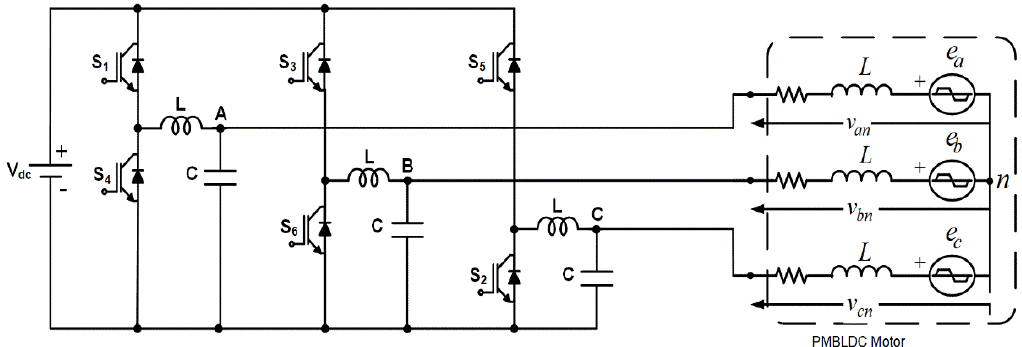
Figure 6. PMBLDC fed by TPRBI for sinusoidal current injection.